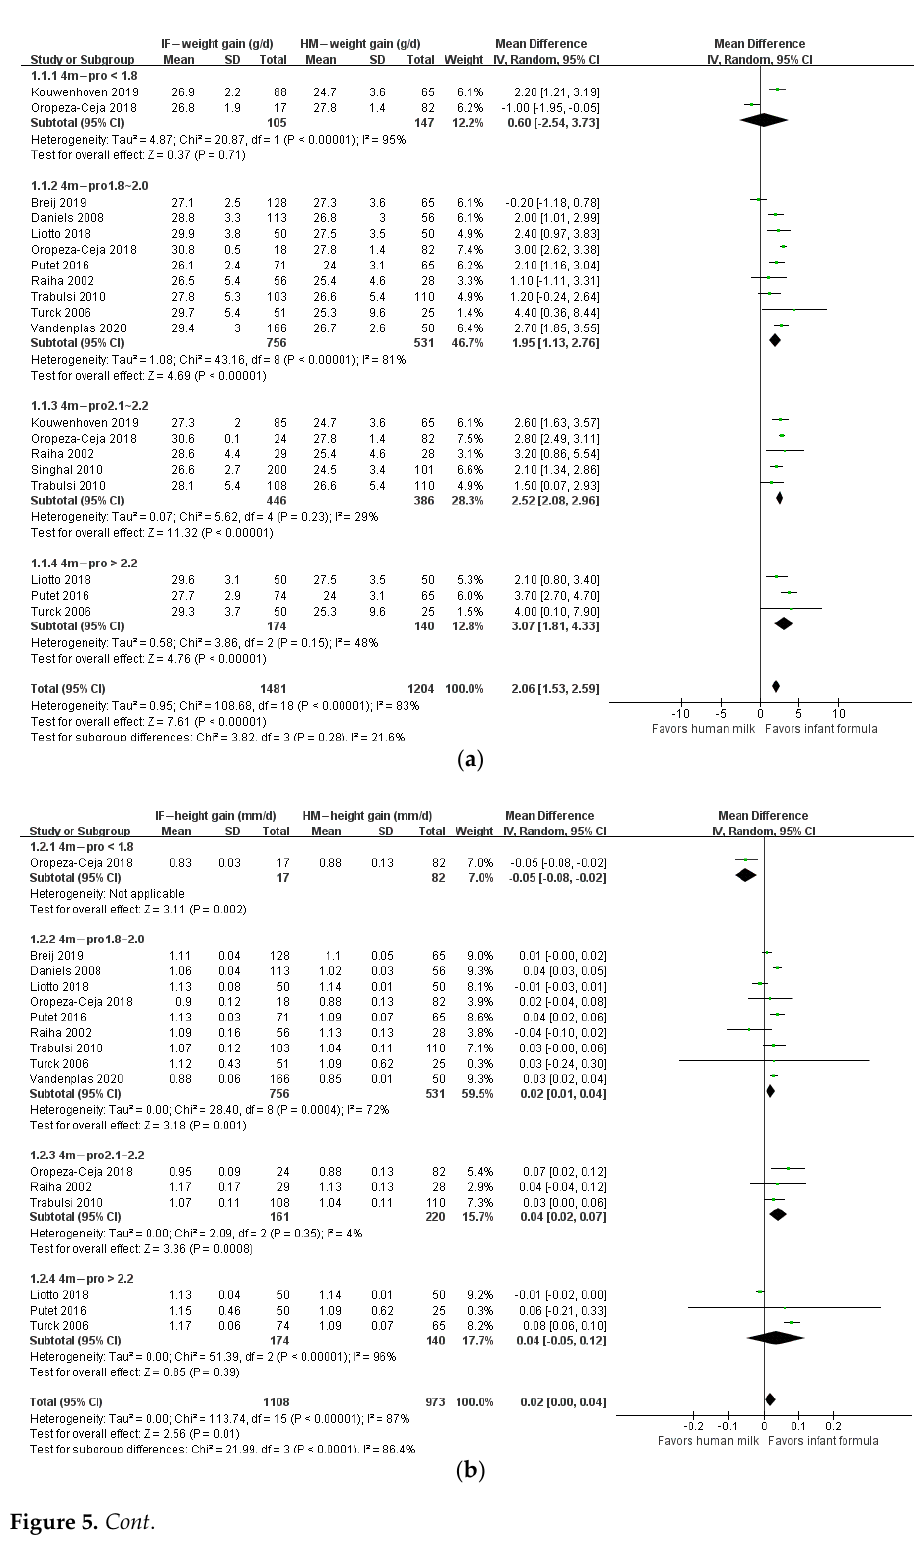
Figure 4. Forest plot of the effects of protein content of infant formula on the weight gain, height gain, and BMI of infants at 3 months of age. ( a ) The effects on weight gain. ( b ) The effects on height gain. ( c ) The effects on BMI.